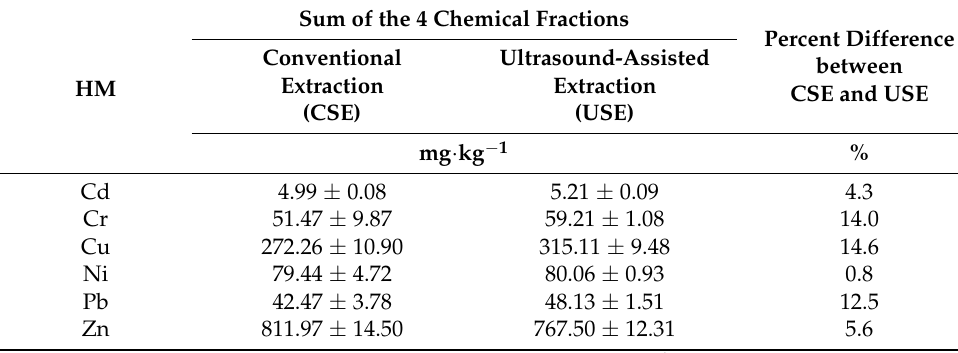
Table 7. The percentage differences between the content of heavy metals in the two methods of sequential extraction in primary sewage sludge.